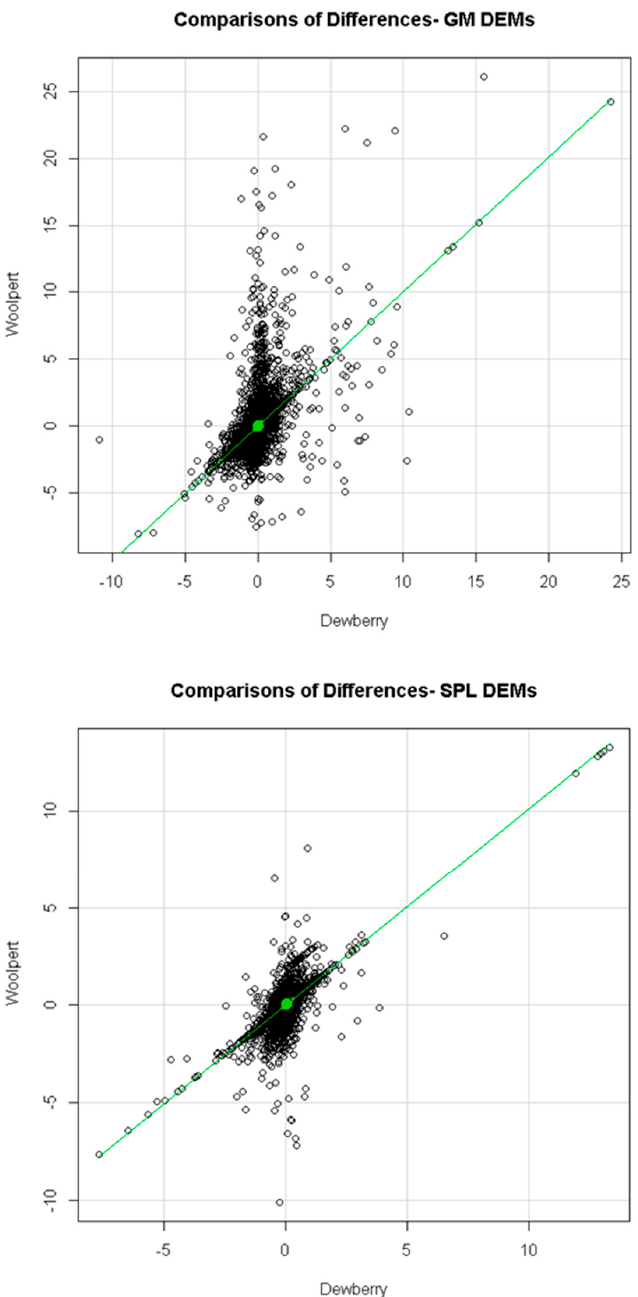
Figure 7. Correlations between Dewberry’s and Woolpert’s IntelliEarth™ DEM differences ( top ); and HRQLS DEM differences ( bottom ) from accepted 3DEP lidar. r = 0.74 and 0.55, respectively.